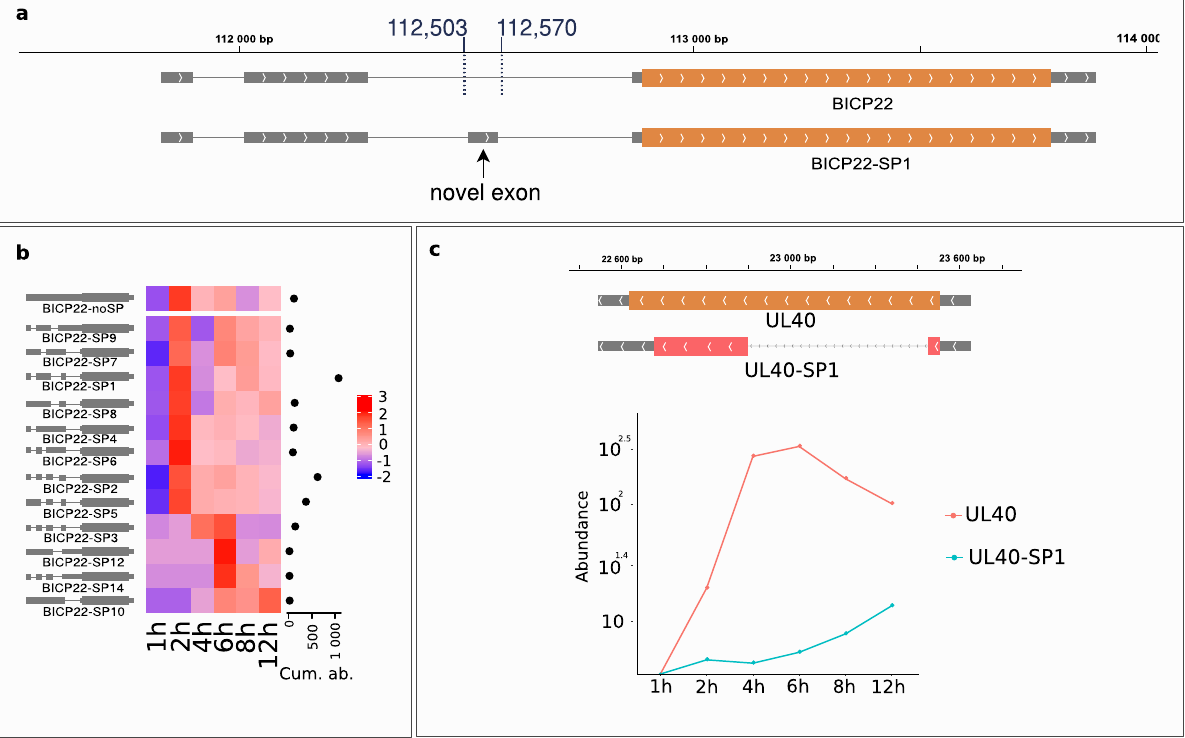
Figure 5. Novel splice variants of BoHV-1. Grey rectangles represent coding transcripts. The wider overlapping orange rectangles are ORFs. Lines between the rectangles represent introns. The orientation of the transcript is represented by arrow heads. ( a ) A novel 67 nt long exon was detected overlapping the second intron of the previously detected bICP22 isoform. The isoform lacking this exon was detected in very low abundance. ( b ) The change of the expression of specific bICP22 splice isoforms. The scale of the heat map represents Z-scores. The cumulative abundance of each splice isoform is represented by the horizontal dot plot on the right of the heat map. Most of the isoforms show a similar early expression pattern as the most abundant transcript, whereas bICP22-SP3, bICP22-SP10, bICP22-SP12, bICP22-SP14 are expressed more during the later phases of